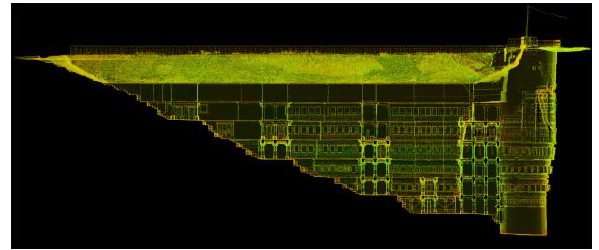
Figure 9. Point cloud cross section through the Rani ki Vav stepwell © CDDV 2012.